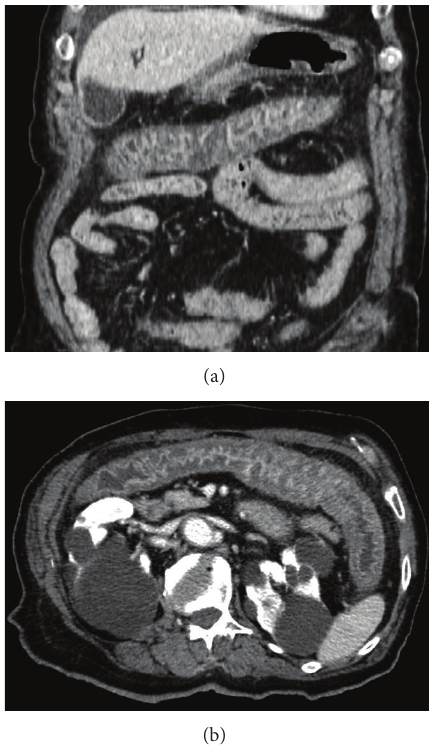
Figure 3: MPR CT images documenting parietal thickening and venous engorgement of the transverse colon (a,